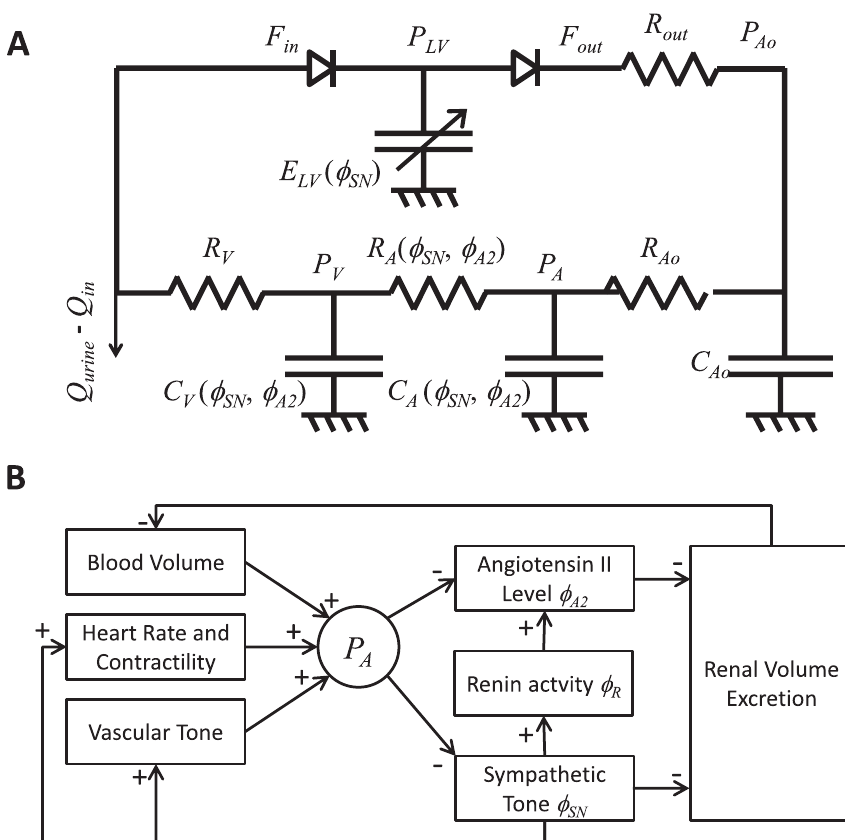
Figure 4. Overview of the whole-body model. A. Diagram of cardiovascular circuit model representing the systemic circulation. Flows entering and exciting the heart are denoted F left-ventricular pressure is denoted P